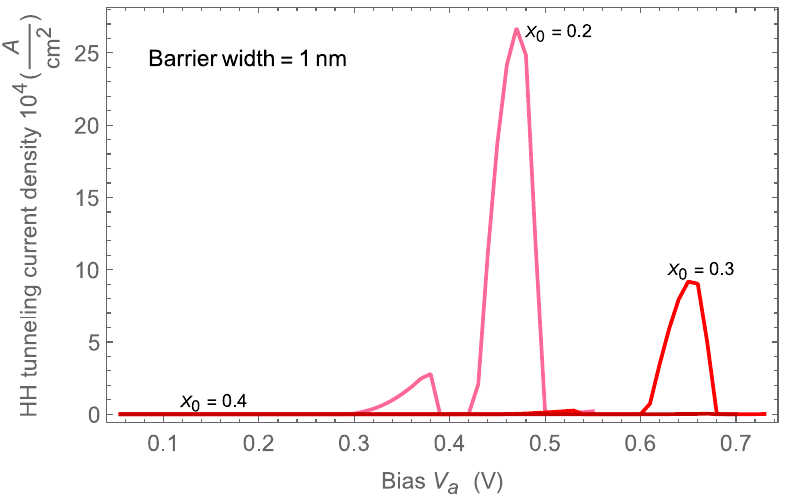
Figure 13. Current density-voltage characteristics of the HH tunneling at width barrier 1 nm.